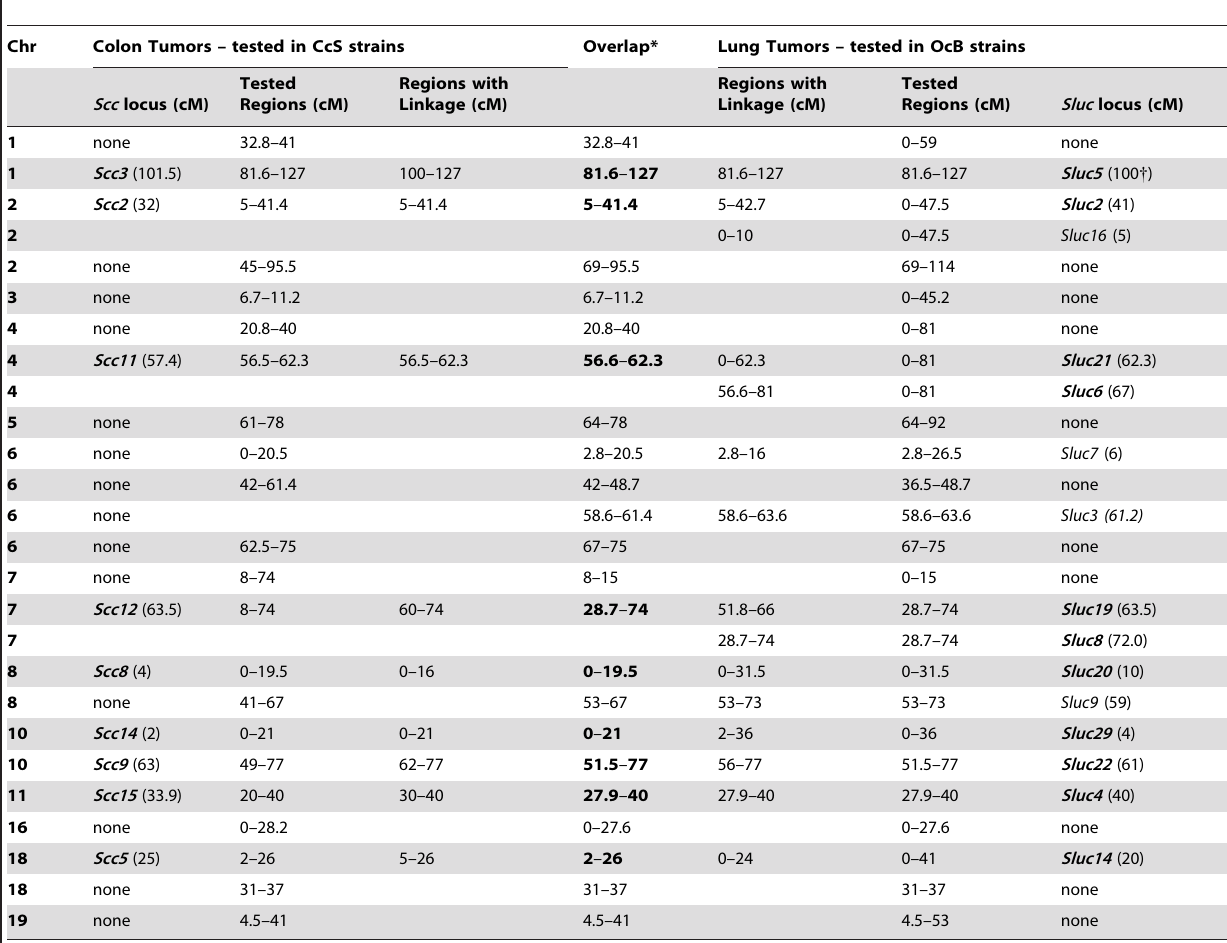
Table 1. Sluc and Scc loci identified independently in OcB and CcS strains frequently co-localize in the same donor chromosomal